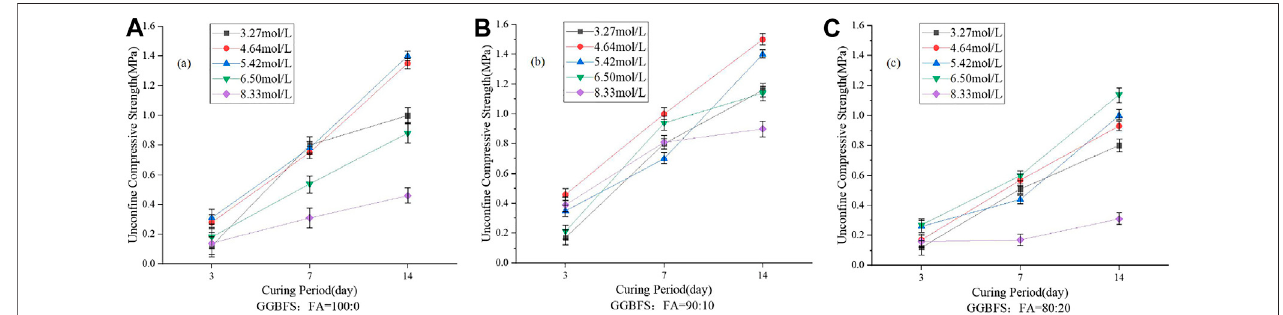
FIGURE 6 | UCS of soil stabilized by geopolymers with different molar concentrations of NH